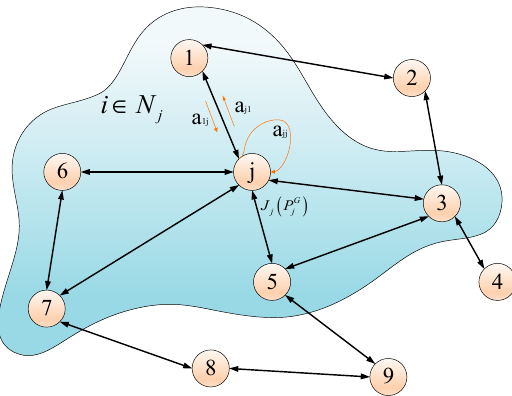
Figure 3. Neighborhood agents of agent j (the highlighted area).